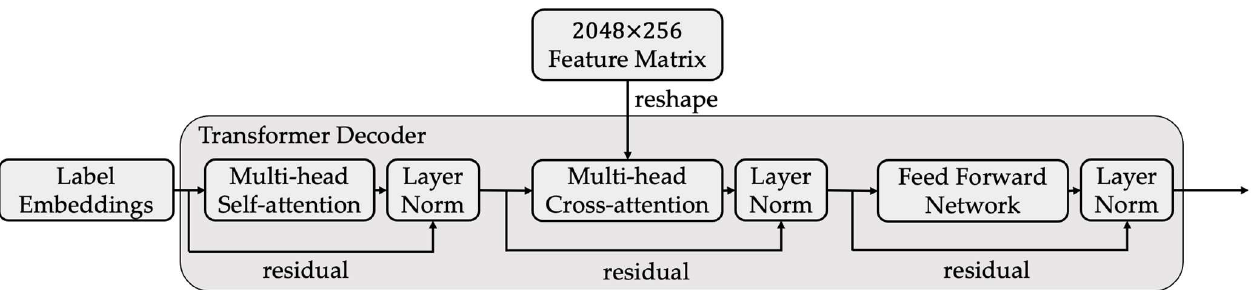
Figure 4. The transformer decoder of the paper.